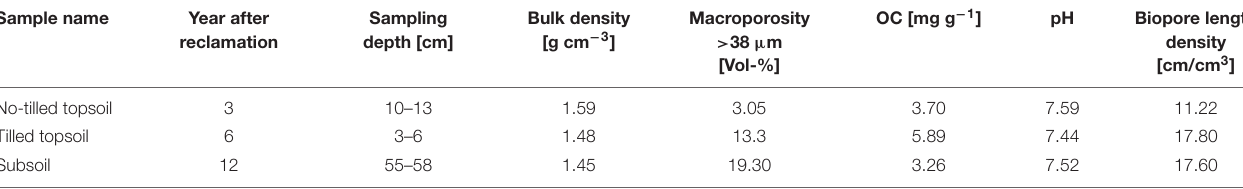
TABLE 1 | Basic soil parameters from selected